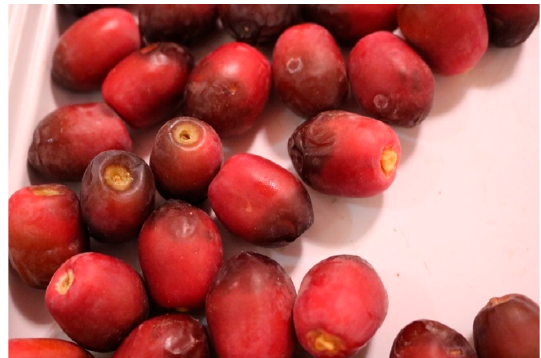
Figure 11. Sample of Al-khasab